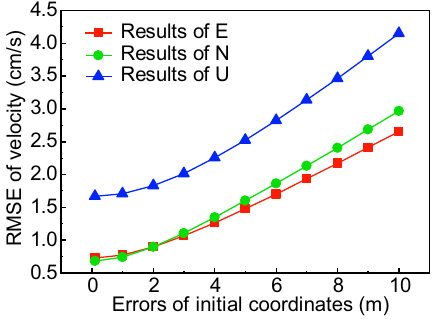
Fig. 4 Errors of velocity determination in the east (E), north (N), and up (U) directions with different initial coordinates and visible LEO satellites vehicle (SV) at station SCOR